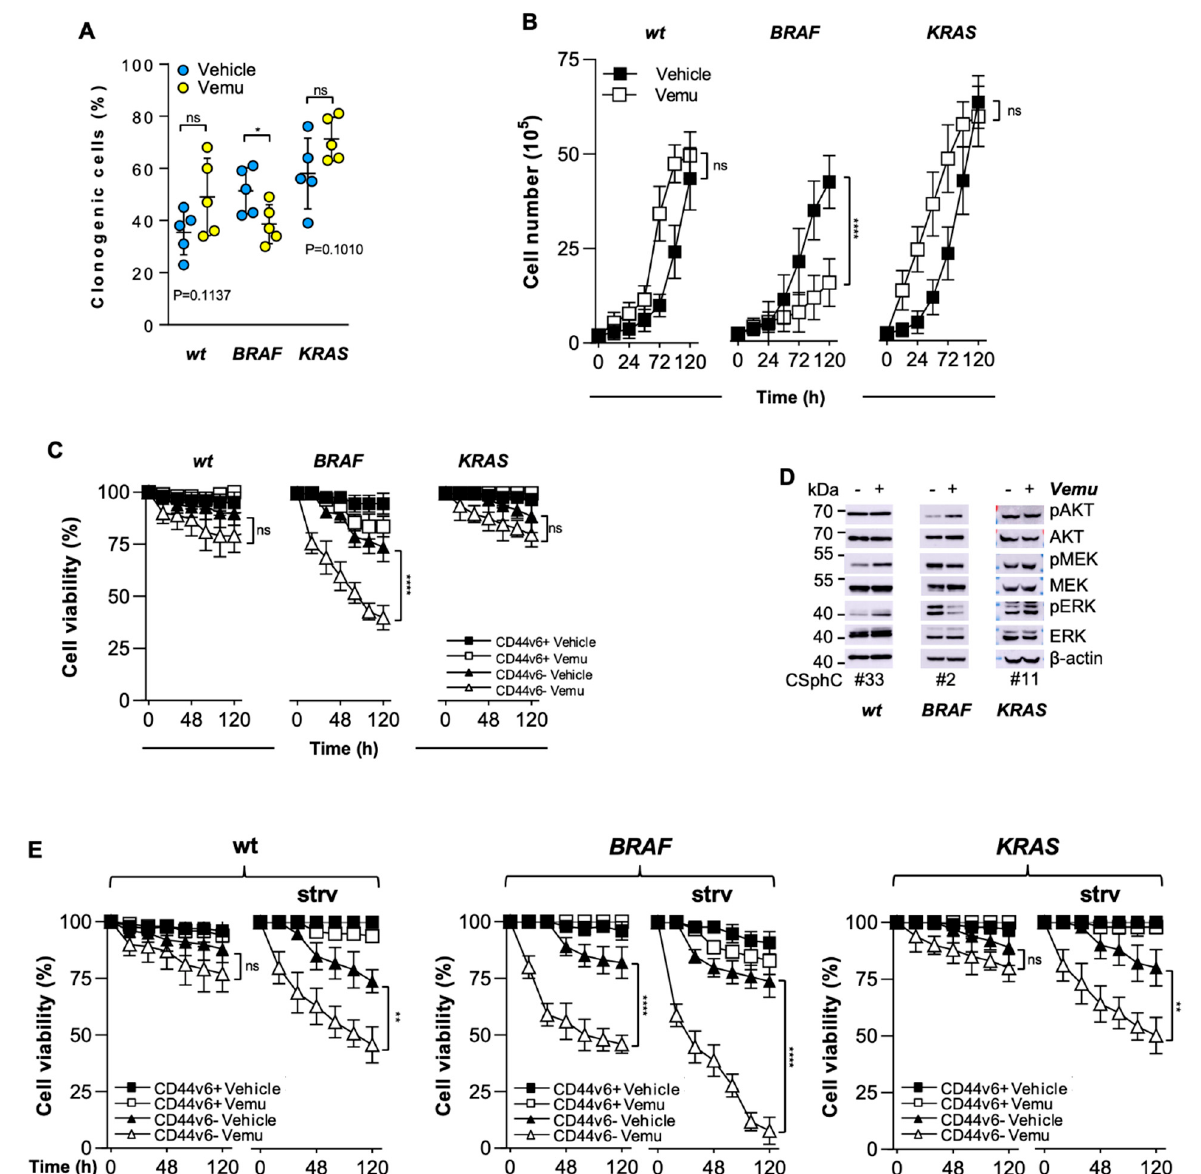
Figure 1. The resistance of CD44v6-positive CR-CSCs to BRAF inhibition is mediated by EGFR-driven MAPK pathway activation. ( A ) Clonogenic assays for wt (#6, #14, #21, #27, #33), BRAF - (#1, #2, #3, #4, #5) and KRAS -mutant (#9, #10, #11, #13, #16) CSphCs pretreated with a vehicle (Vehicle) or vemurafenib (Vemu, 1 µM) for 120 h. The statistical significance between two groups was determined with a paired two-tailed Student’s t -test. ( B ) Kinetics of wt (#14, 21), BRAF - (#2, 5) and KRAS -mutant (#11, 16) sphere cell growth following treatment with vemurafenib (Vemu, 1 µM) for up to 120 h. ( C ) Cell viability percentage of CD44v6 + and CD44v6 – wt (#21, #27, #33), BRAF - (#1, #3, #5) and KRAS -mutant (#9, #13, #16) sphere cells treated as in ( B ). ( D ) Immunoblot analysis of pAKT, AKT, pMEK, MEK, pERK and ERK on the indicated CR-CSphCs treated with a vehicle (-) or vemurafenib (Vemu, +, 1 µM) for 48 h. ( E ) Cell viability percentage of CD44v6 + and CD44v6 – wt (#21, #27, #33), BRAF - (#1, #3, #5) and KRAS -mutant (#9, #13, #16) sphere cells treated as indicated in the presence or absence (strv) of EGF for up to 120 h. For B–C and E, data are means ± SD from three independent experiments. ns, not significant; * p ≤ 0.05; ** p ≤ 0.01, **** p ≤ 0.0001. The uncropped blots are shown in supplementary materials.